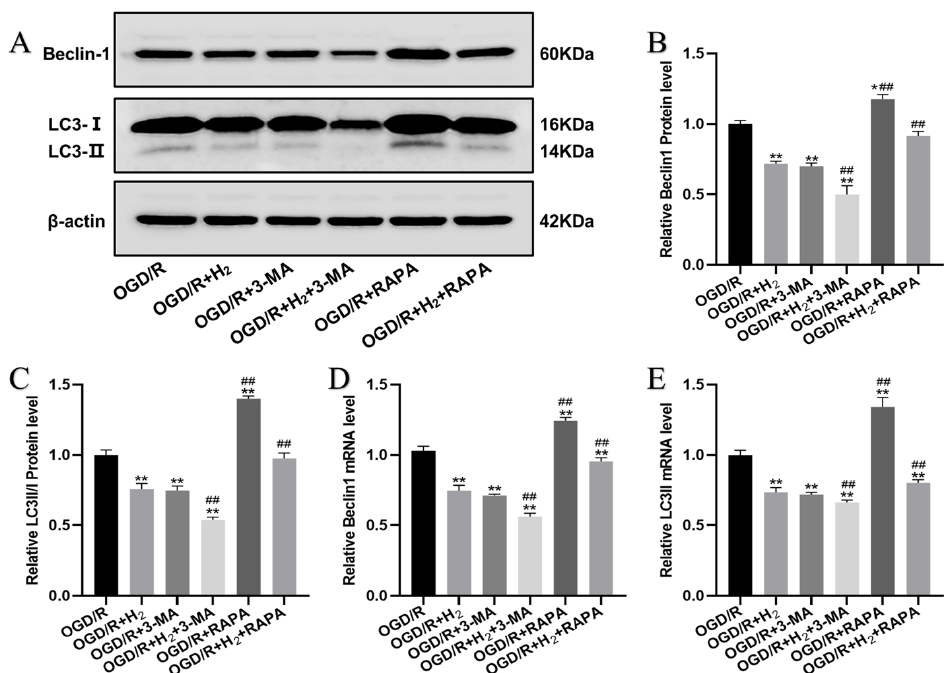
Figure 5. The effect of H 2 on autophagy. ( A ) Sample bands from a Western blotting experiment. ( B , C ) Quantification of Beclin-1 and LC3-II proteins per group, respectively. ( D , E ). Levels of Beclin-1 and LC3-II mRNA expression per group. A minimum of three separate repetitions of the experiments produced similar findings. * p < 0.05, ** p < 0.01 vs. OGD/R group. ## p < 0.01 vs. OGD/R+ H 2 group.